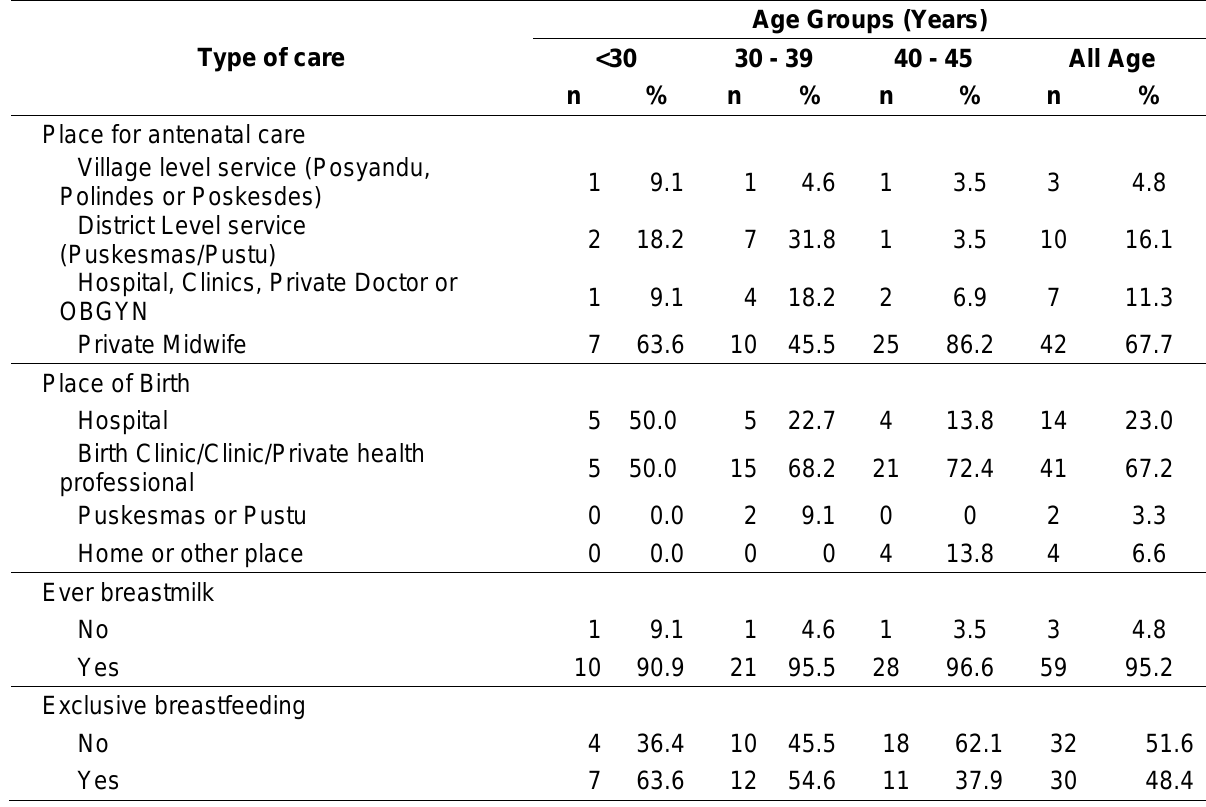
Table 3. Maternal and child health care-seeking behaviour for the last pregnancy in women aged 15 – 45 years